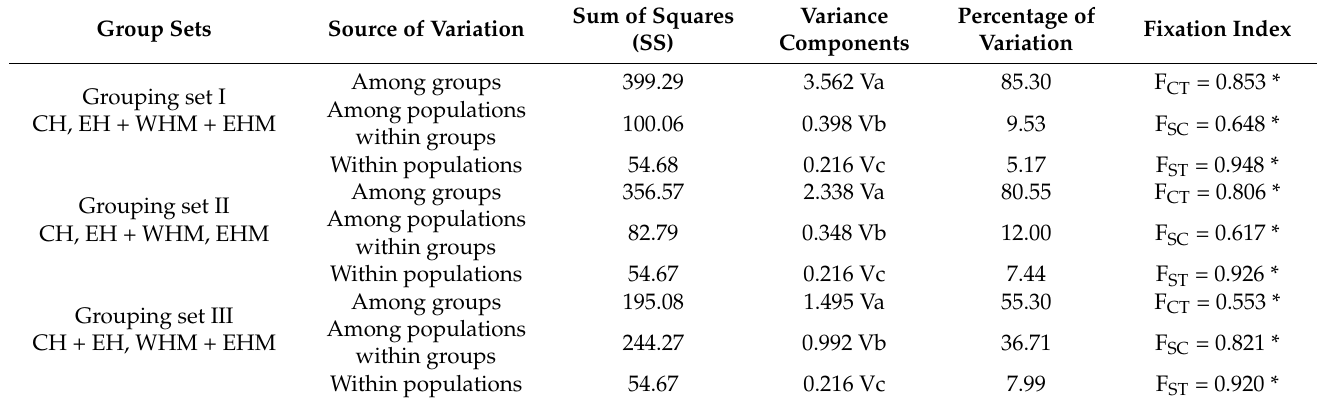
Table 2. Results of AMOVA analyses of groups. Populations were divided into six basic groups in Table 2. F SC represents variance within groups; F CT represents variance among groups * = p < 0.05.